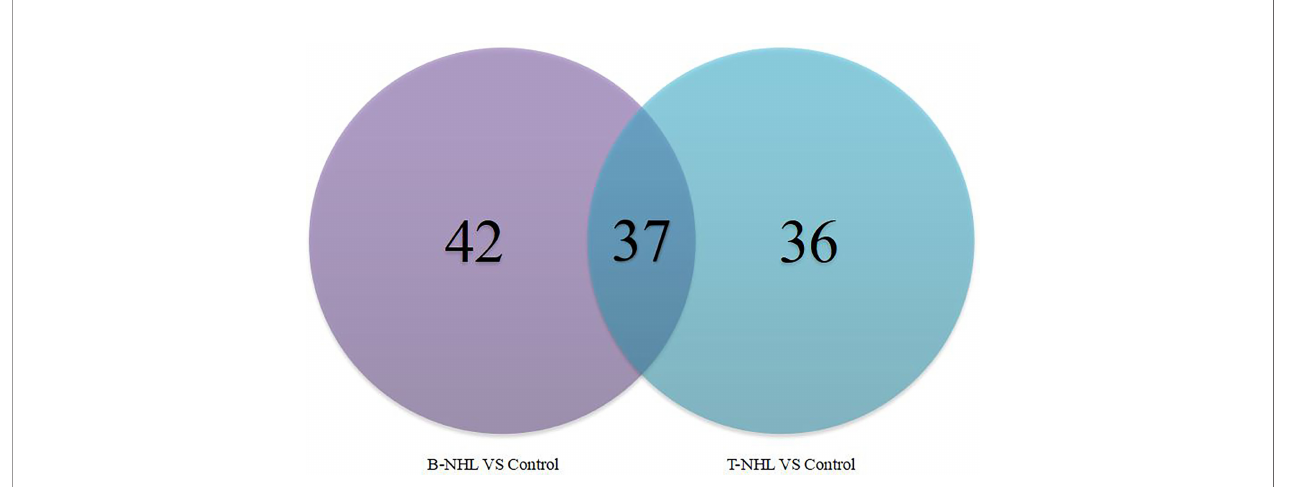
FIGURE 2 | Venn diagram indicating the serum differentially expressed proteins between the pediatric B-NHL and T-NHL groups and the control group.